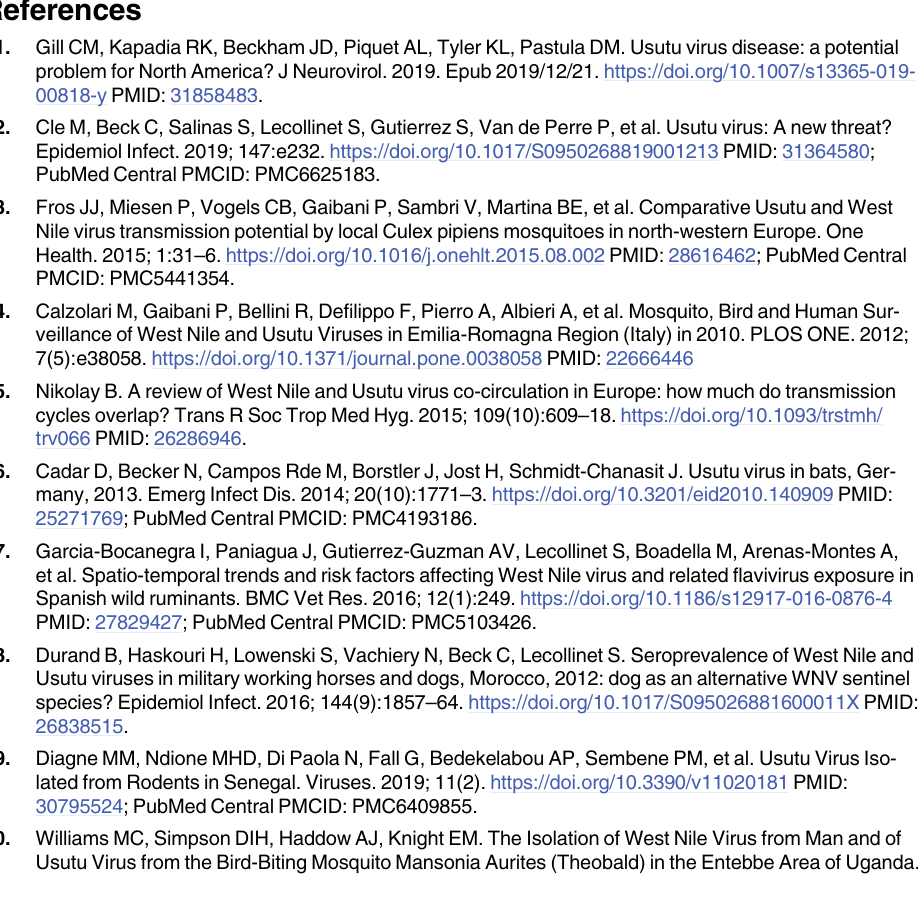
S1 Table. List of amino acid differences of four recent USUV isolates relative to the proto- type strain, South Africa 1959. Amino acid differences are highlighted in bold